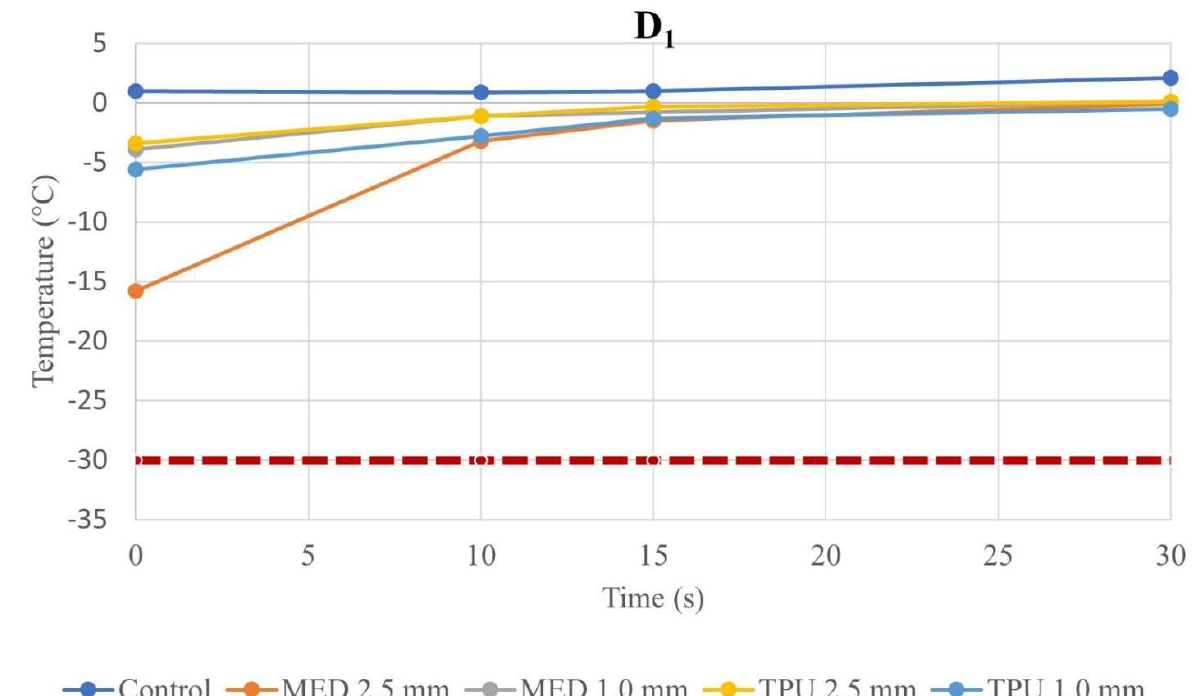
Figure 3. Temperature–time curve of control and biomaterial samples in D 1 . The graph represents the temperature–time curve at D 1 from the cryoablation catheter of the control, MED625FLX and TPU95A of 1.0 and 2.5 mm of thickness; the dashed line indicates the threshold set at −30.0 °C. Below the threshold, the freezing causes cell death.